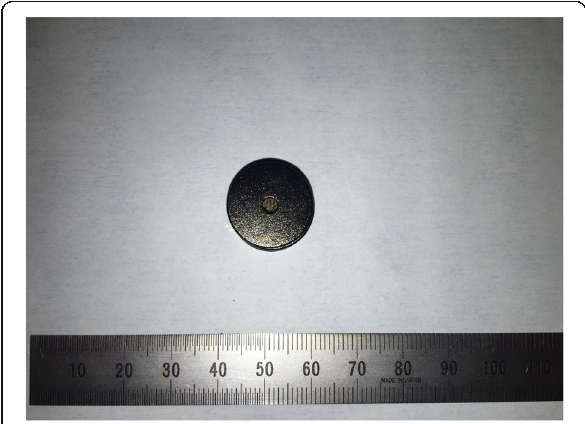
Fig. 3 The magnets used for MCA (parent magnet = daughter